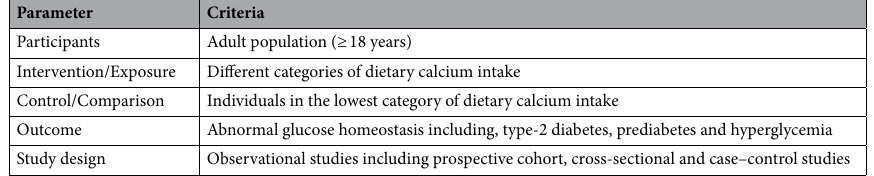
Table 1. PICOS criteria for inclusion of